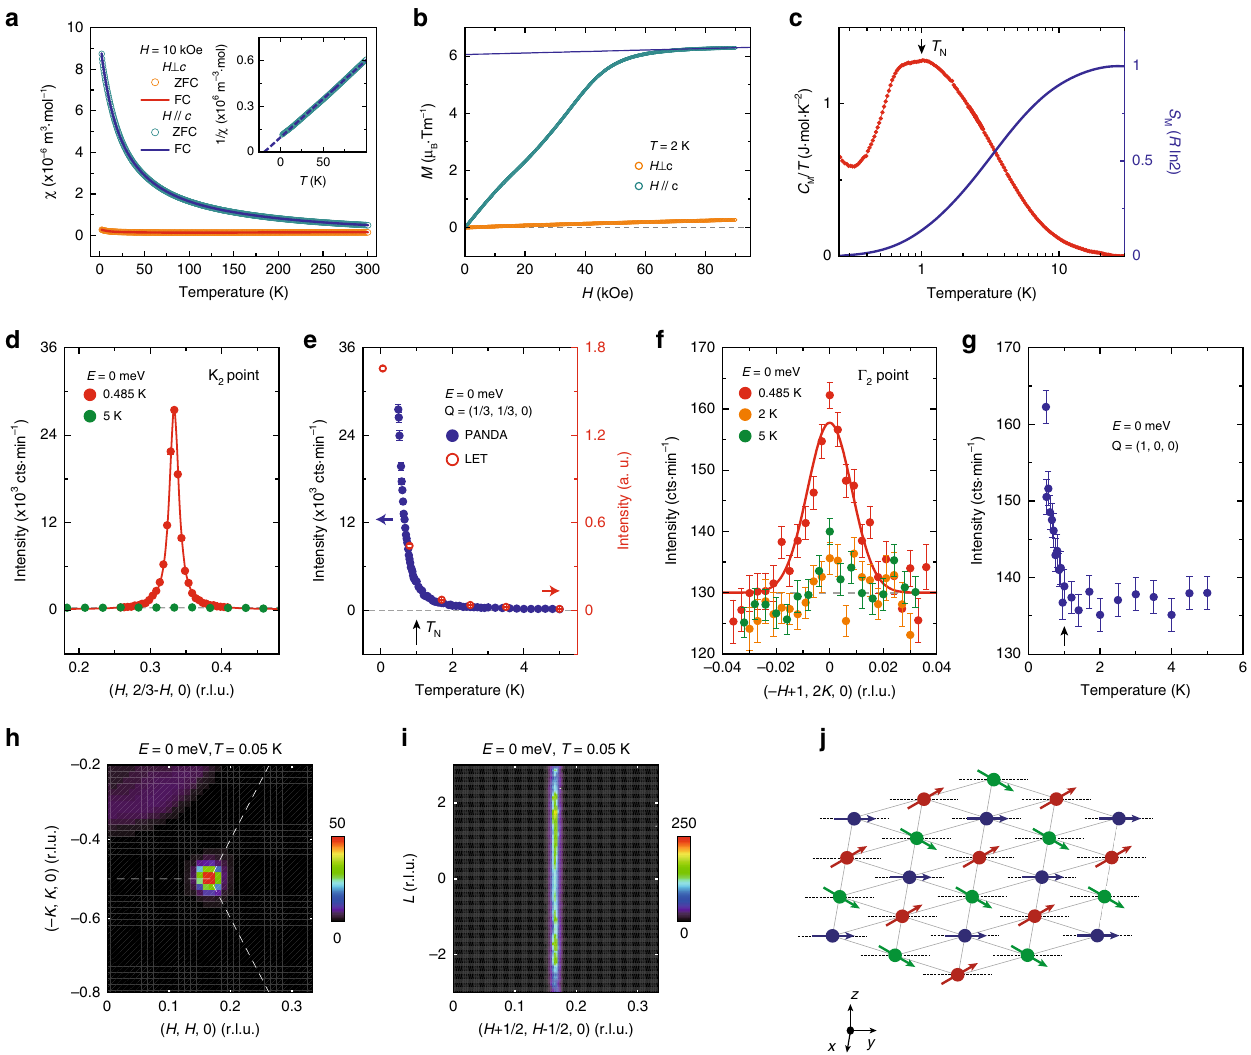
Fig. 1 Thermodynamic property and neutron diffraction measurements of TmMgGaO 4 single crystals. a Temperature dependence of the magnetic susceptibility χ measured under ZFC and FC conditions with external fi elds of 10 kOe applied parallel and perpendicular to the c axis. The inset shows the linear fi tting of the inverse susceptibility. b Field dependence of the magnetization at T = 2 K. Linear fi tting of the magnetization at high fi eld indicates the Landé- g factor of 12.11(5). c Magnetic heat capacity and magnetic entropy measured under zero fi eld. The phonon contribution is subtracted by comparing measurements of TmMgGaO 4 with the non-magnetic reference compound LuMgGaO 4 . The magnetic entropy is obtained by integrating C / T from 0.25 K. Indication of a Schottky anomaly is observed below 0.4 K, which is likely caused by the strong hyper fi ne interactions. d Q -scans across the magnetic Bragg peak Q = (1/3, 1/3, 0) along the transverse direction at the indicated temperatures. e Temperature dependence of the fi tted peak amplitudes of the Bragg peak at Q = (1/3, 1/3, 0). f Q -scans across the multipolar Bragg peak Q = (1, 0, 0) along the transverse direction at indicated temperatures. g Temperature dependence of the intensity of the Q = (1, 0, 0) peak. The solid and dashed lines in d – f are guides to the eye. h Momentum dependence of the magnetic Bragg peak at 0.05 K. The white dashed lines indicate the zone boundaries. i L dependence of the peak intensity at Q = (2/3, − 1/3, L ). The color bars indicate scattering intensity in arbitrary unit in linear scale. j Schematic of the three-sublattice magnetic structure of TmMgGaO 4 . S y forms ferro-multipolar order along the y direction (black dashed lines) and S z forms dipolar order (spin up — red, spin 0 — blue, spin down — green). The red and green arrows are tilted from the xy plane by ∼ 32°. The data shown in d , f and g were measured on PANDA and the data in h , i were measured on LET. The wavevector Q is de fi ned as Q = H a * + K b * + L c *; r.l.u. reciprocal lattice unit, cts min − 1 counts per minute; error bars, 1